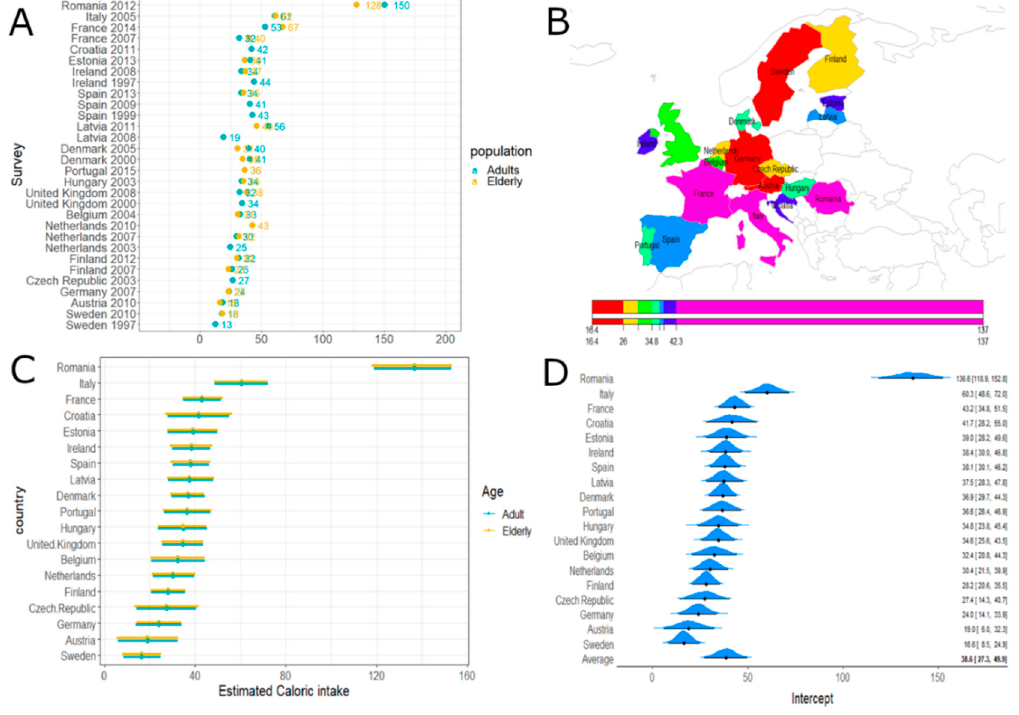
Figure 3. Vegetable caloric intake. Panel ( A ): Vegetable and vegetable products’ caloric intake (obtained by summing the means over the L7 levels) according to surveys and age classes. Panel ( B ): Estimated caloric intake across European countries. Panel ( C ): Estimated caloric intake across European countries according to age classes with 95% credibility intervals. Average effect estimate (95% CI) 38.59 [27.25; 49.90] and age effect (95% CI) 2.48 [–4.97; 4.83]. Panel ( D ): Estimated caloric intake across European countries (without age effect) with 95% credibility intervals.